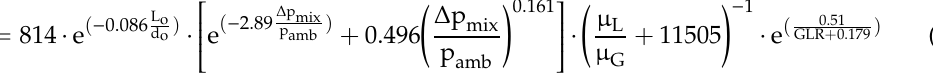
Figure 12. The inlet turbulence intensity (Tu 1 ) for the continuous single phase entering the mixing chamber for the tested atomizers at the condition of GLR = 1 .2%, ∆p mix /p amb = 0.98, and µ L /µ G = 55.